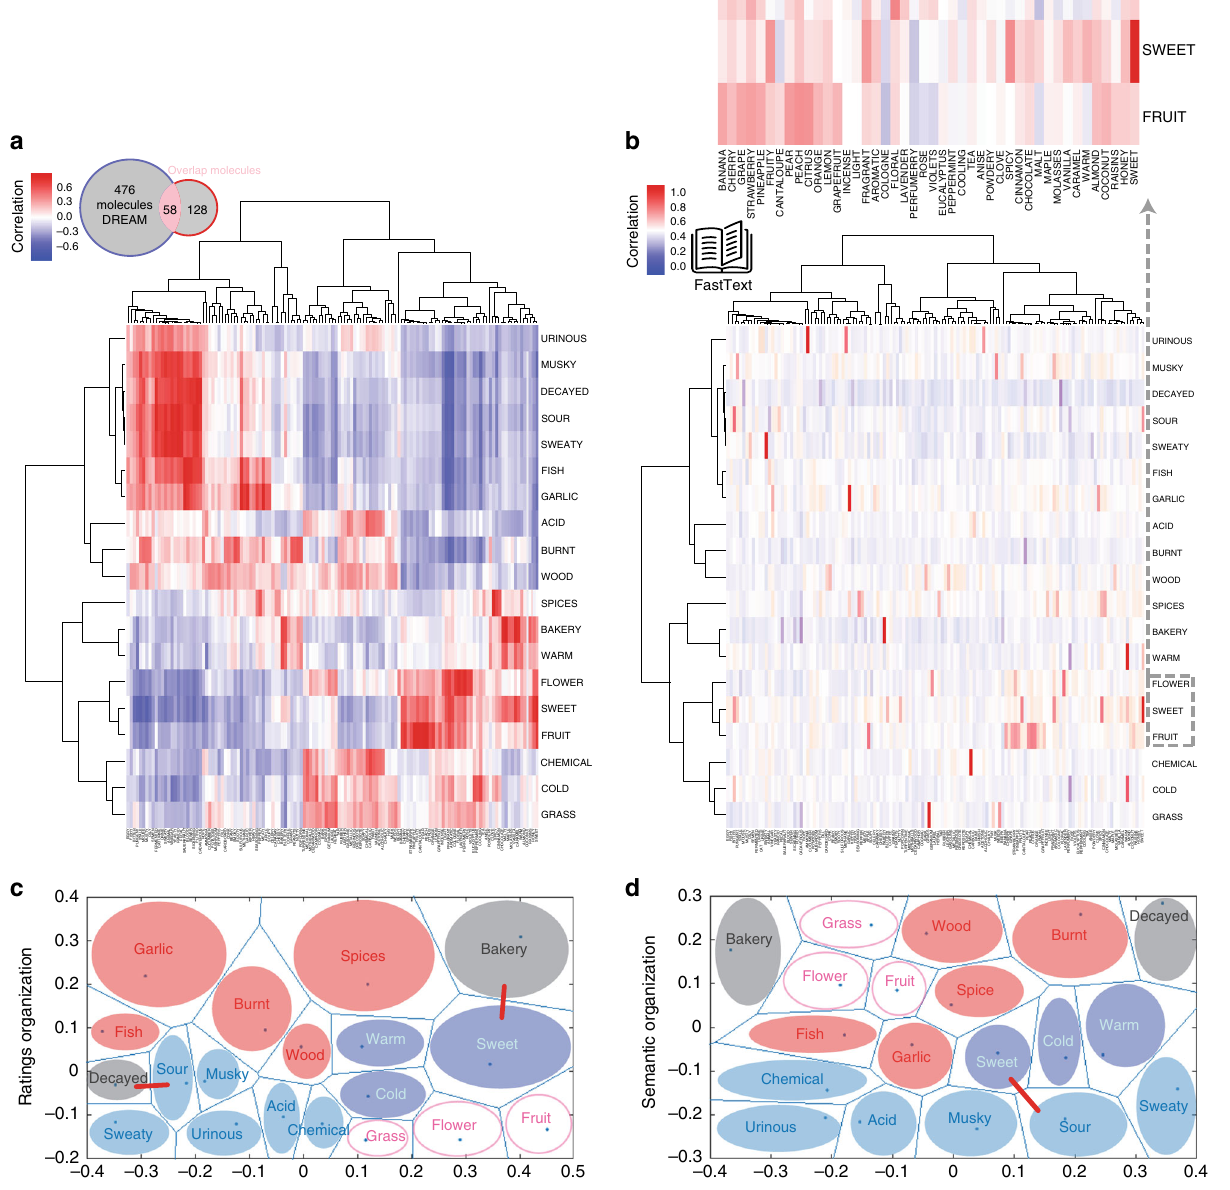
Fig. 2 Olfactory-perceptual map and semantic structure similarities. a Heatmap showing correlations between the ratings of the Dravnieks descriptors (horizontal axis) and the DREAM descriptors (vertical axis) across the 58 shared molecules. Descriptors are arranged using hierarchical clustering, showing that they naturally cluster into semantically interpretable categories in the perceptual ratings correlation space. b Heatmap showing the correlation for the semantic vectors of the DREAM descriptors (horizontal axis) to the semantic vectors of the Dravnieks descriptors (vertical axis). Descriptors are arranged using the hierarchical clustering of a in order to allow direct comparison and emphasize common structure. Top: zooming in on one of the semantic clusters. Weights are not always highest between identical Dravnieks and DREAM descriptors (e.g., “ fl ower ” ). c Organization of descriptors in the olfactory rating space through a 2D dimensionality-reduction based on the intrinsic similarity between the ratings representation of the descriptors across all molecules in the DREAM dataset. d Organization of descriptors in the olfactory rating space through a 2D dimensionality-reduction based on the intrinsic similarity between the semantic representation of the descriptors in the DREAM dataset. Note the locality preservation of descriptor groups, identi fi ed by colors (e.g., pink for “ grass, ” “ fl ower ” and “ fruit ” ), and the global distortion due to the proximity of the antonyms “ sweet ” and “ sour ” shown with a red bar in the semantic space, in turn mapped close to the perceptually closer “ bakery ” and “ decayed, ” respectively, shown with a red bar